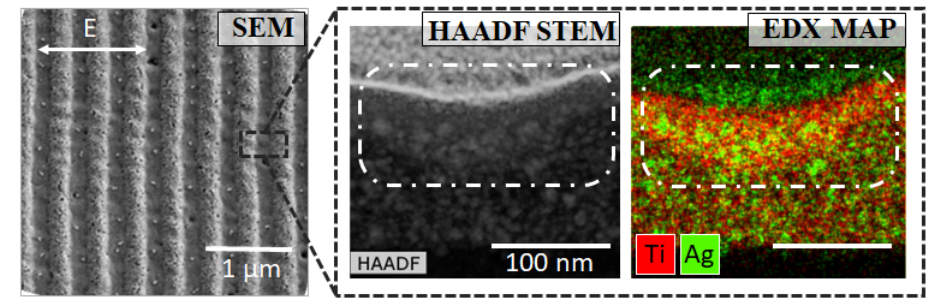
Figure 3. SEM, HAADF STEM and EDX map images of the structure (i) (N = 540, F = 21 mJ/cm 2 ). Dash-dotted outline shows the densification area.